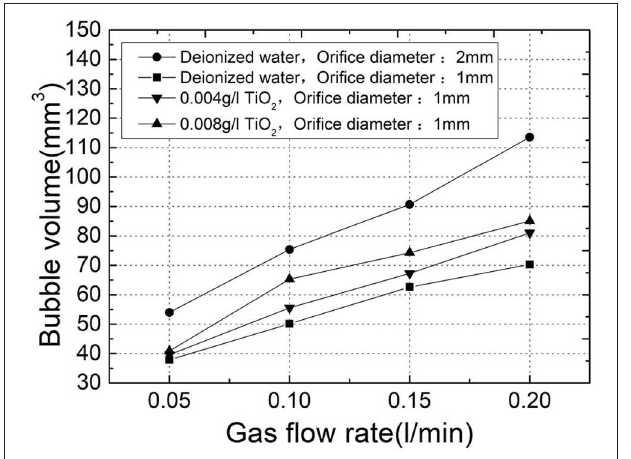
FIGURE 2 | Effect of different TiO 2 concentration on bubble volume generation.